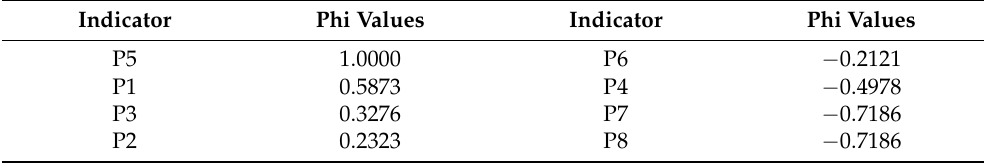
Table 14. PROMETHEE II results for physical aspect of healthcare facilities.